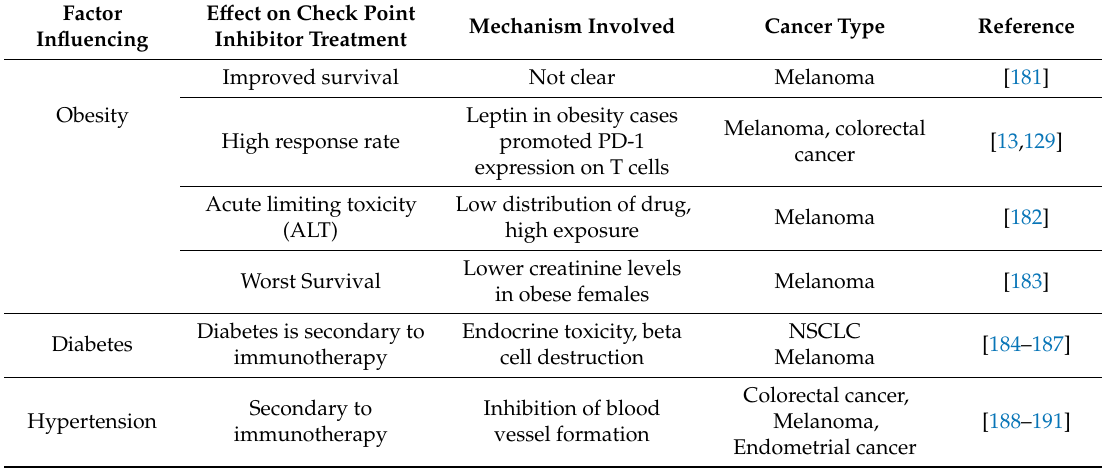
Table 4. E ff ect of metabolic diseases on CPI